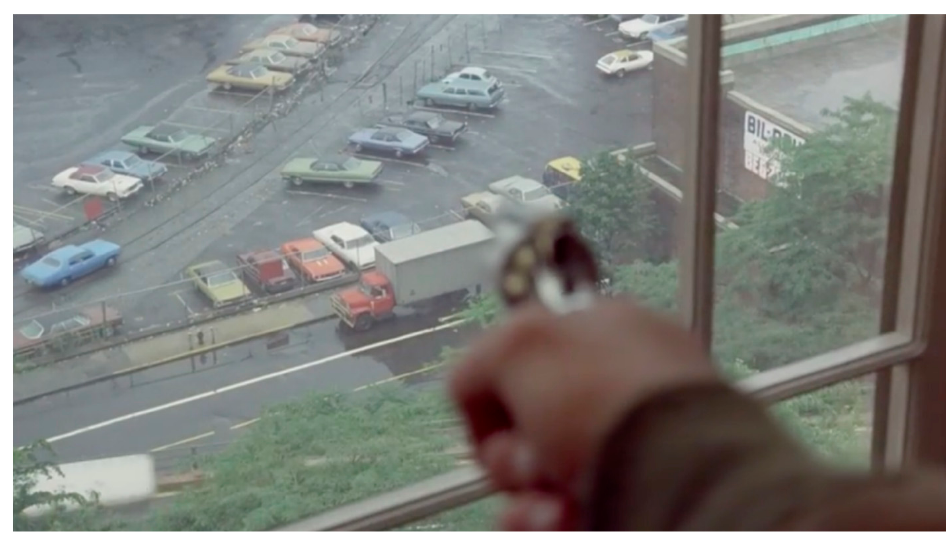
Figure 8. Image from Taxi Driver (1976) [36].